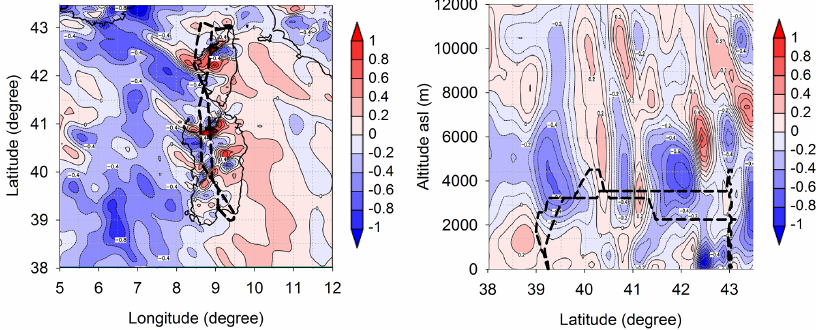
Figure 12. Wind vertical velocity (in Pas − 1 ) at 700hPa (a) and on the vertical along the F33 flight latitude (b) , from the 10km resolution WRF model simulations. The dashed line shows the flight